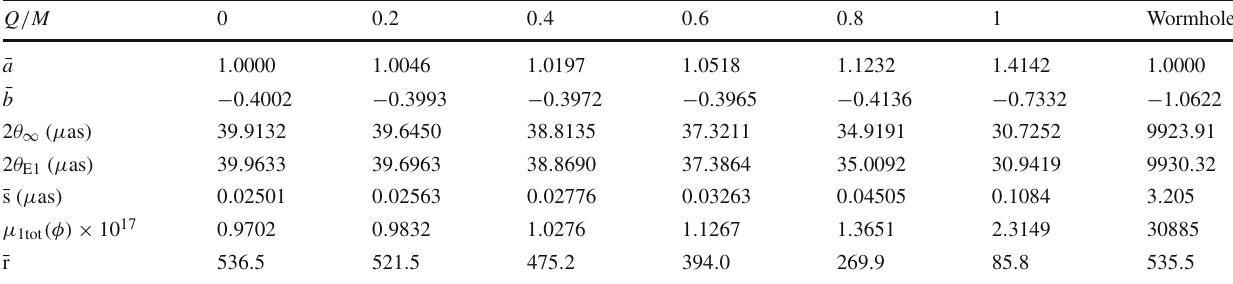
Table 1 Gravitational lensing in a usual lens configuration with the deflection angle (1.5): ¯ a , ¯ b , 2 θ ∞ , 2 θ E1 , ¯ s , μ 1tot (φ) , and ¯ r in the Schwarzschild and Reissner–Nordström black hole spacetimes for given Q / M andintheEllis–Bronnikovwormholespacetimeareshown. We set the mass M = 6 . 5 × 10 9 M (cid:10) , distances D os = 33 . 6 Mpc and